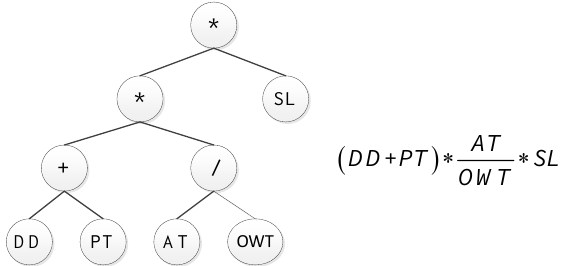
Figure 1. A GP individual tree example and its corresponding dispatching rule.